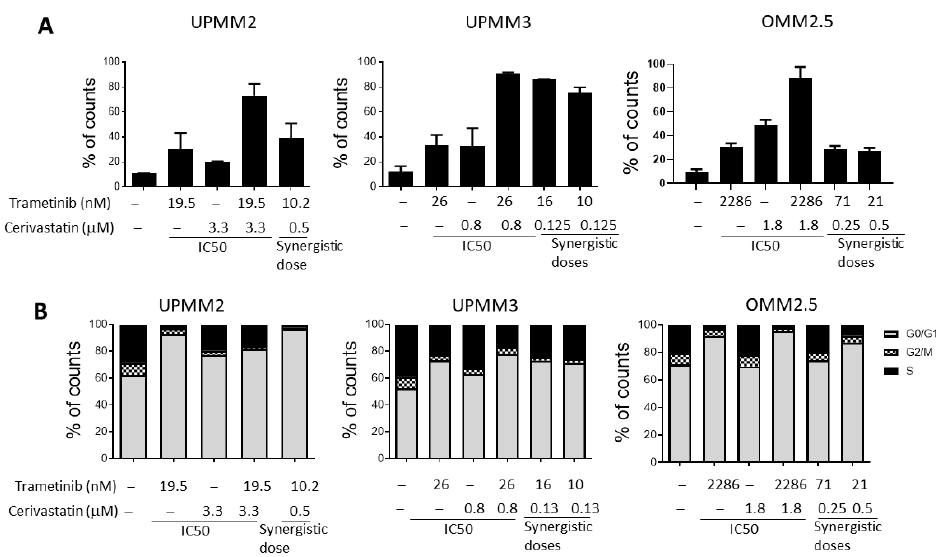
Figure 3. Percentage of apoptotic UM cells (Annexin V + PI+ and Annexin V + PI − ) after treatment with IC50 or the synergistic concentrations of trametinib and cerivastatin ( A ). Data are expressed as mean percentage ± SEM. Stacked histograms showing UM cells distribution in cell cycle phases after treatment for 72 h with IC50 and synergistic concentrations of trametinib and cerivastatin. Data from one representative experiment out of three are reported ( B ).